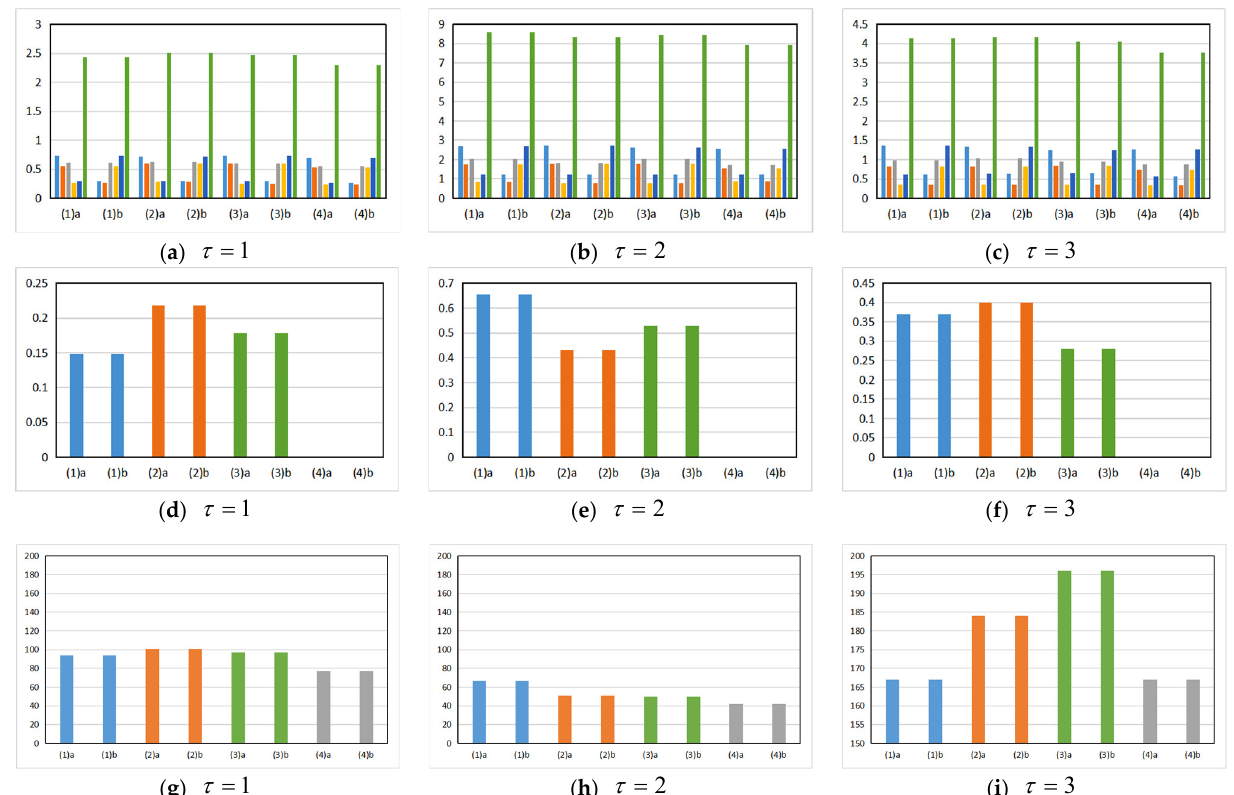
Figure 15. The weight fluctuation for each algorithm and a comparison of the global optimal solution difference values under the different transportation modes. ( a – c ) show the weight tendency of the optimal tour route in different algorithms under the modes. ( d – f ) show the global optimal solution differences in different algorithms under the modes. ( g – i ) show the ferry traveling time of the optimal tour route for each algorithm under different modes.